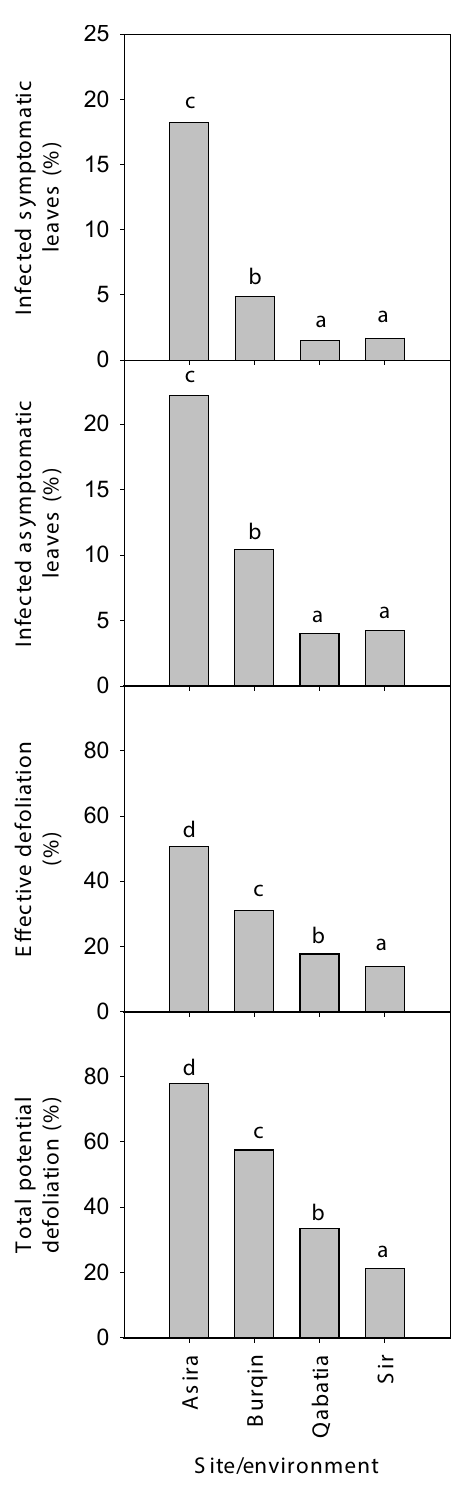
Figure 1. Means of olive tree defoliation and Venturia oleaginea infections as influenced by different sites/environments in Palestine. Means accompanied by the same letter are not significantly differ- ent ( P ≤ 0.05).